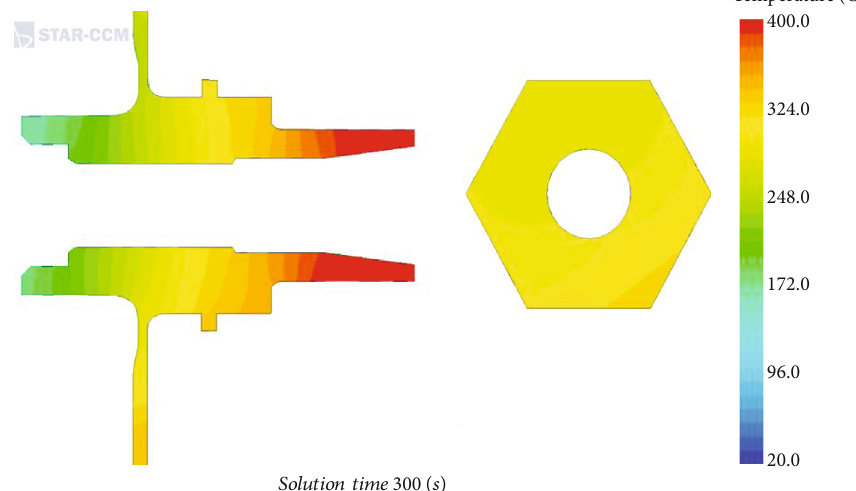
Figure 12: Temperature of the drain valve at t = 5